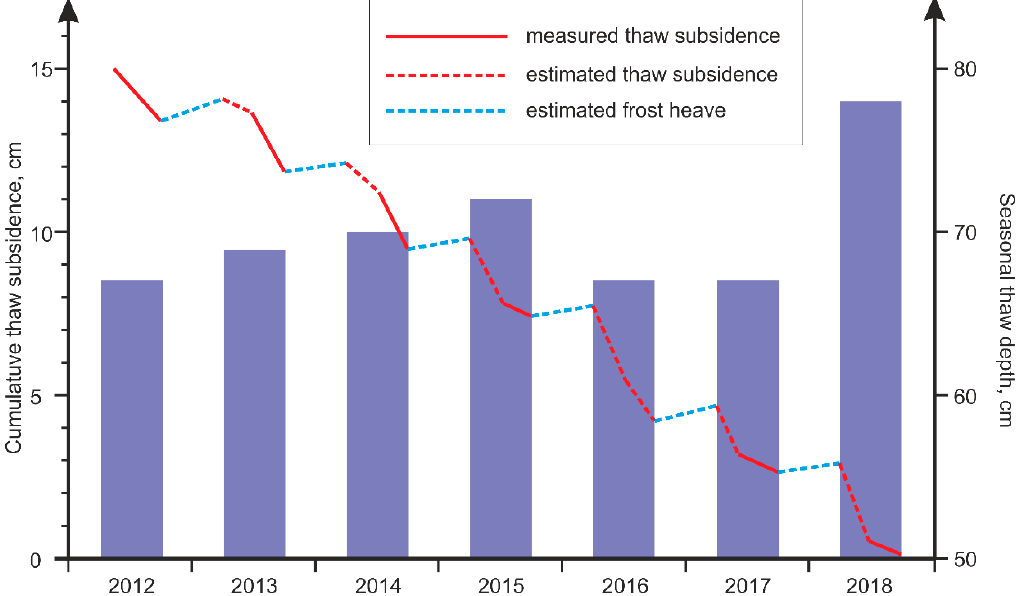
Figure 5. Thaw subsidence and frost heave dynamics for 2012–2018 on Lavrentiya CALM site. ALT (purple bars) is given as averaged value for the whole site.